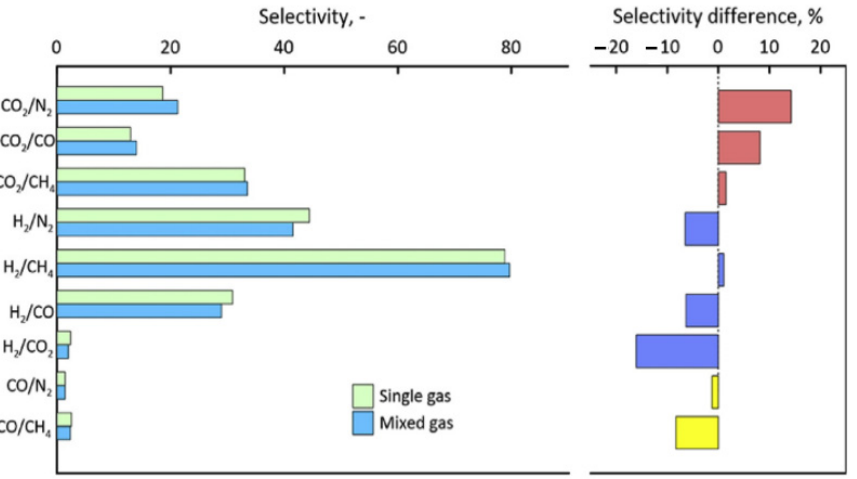
Figure 10. Performance comparison for TR-PBOI single- and mixed-gases hollow-fibre membrane [38].